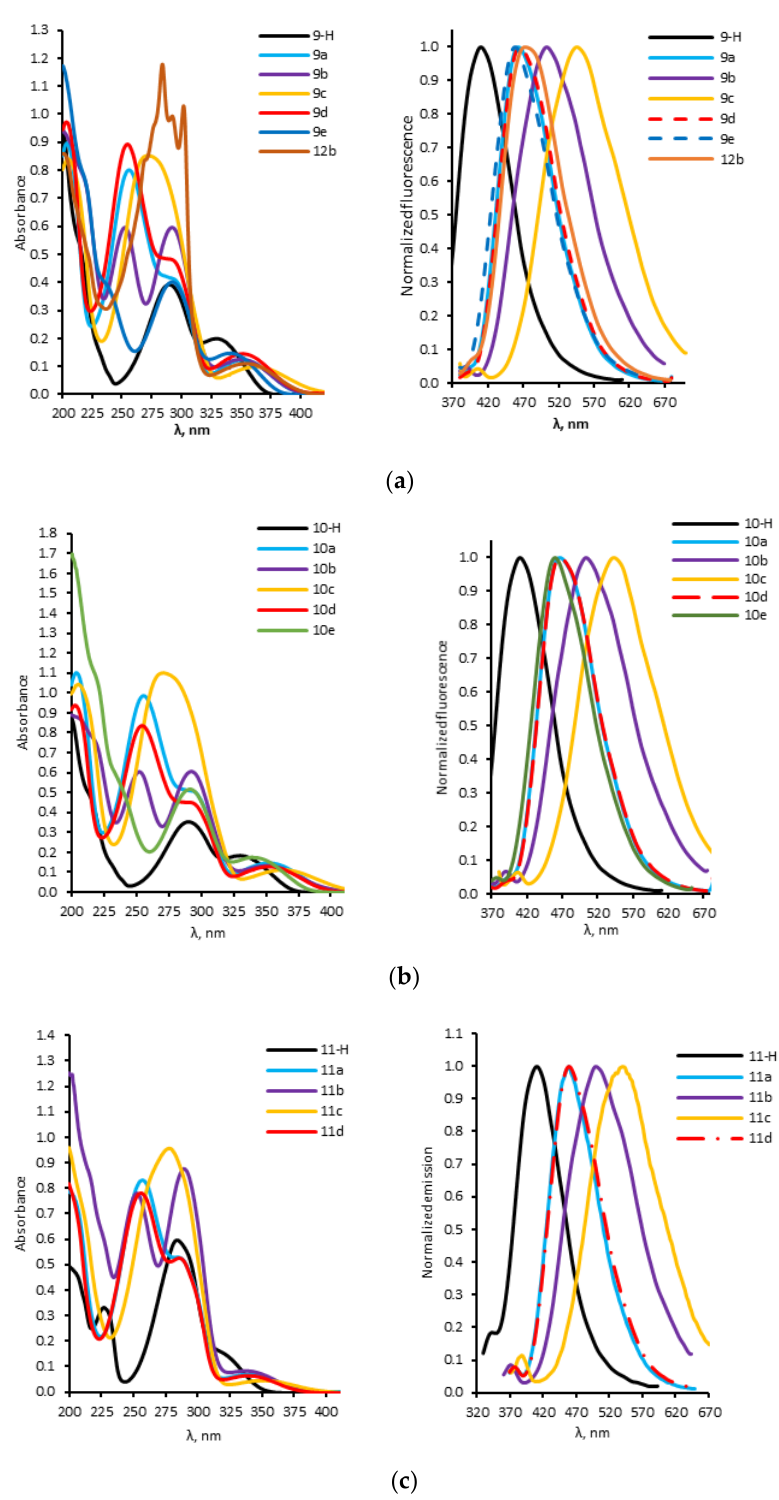
Figure 5. UV-VIS and normalized fluorescence spectra in acetonitrile: ( a ) series of ethyl coumarin-3-carboxylates compounds 9a–e , 12b ; ( b ) series of methyl coumarin-3-carboxylates compounds 10a–e ; ( c ) series of ethyl 2-ethoxybenzo[e][1,2]oxaphosphorine-3-carboxylate 11a–d.